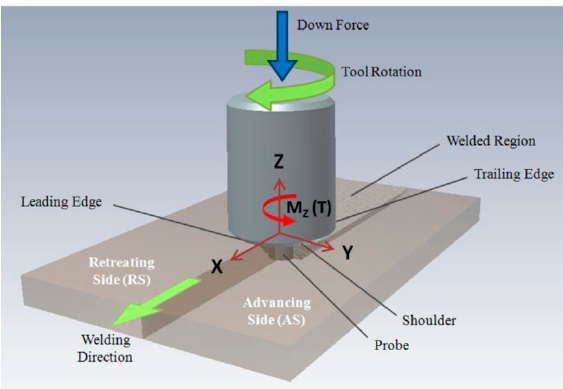
Figure 1. Schematic of friction stir welding, reproduced from [4], with permission from Elsevier, 2014.